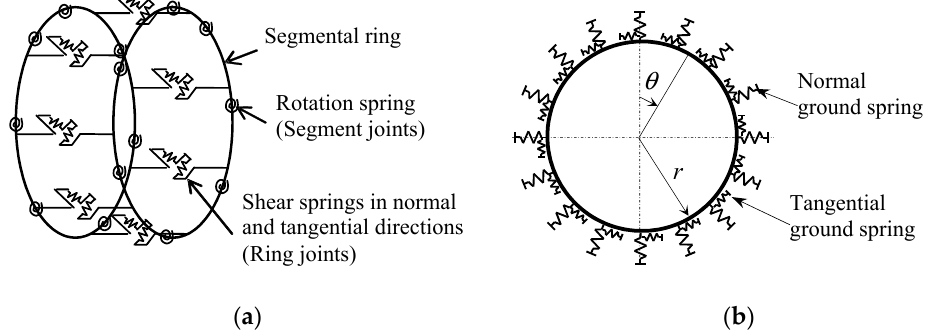
Figure 1. Analysis model. (a) Beam-spring model; (b) Ground spring model.